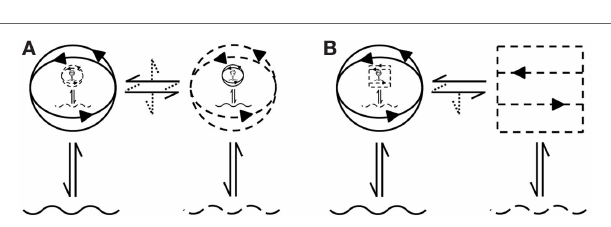
FIGURE 14 | Pictographic representation (Moore, 2016a) of language-based coupling (dialog) between interlocutors. In (A) , communicative interaction between human beings is founded on two-way ostensive recursive mind-reading (including mutual Theory-of-Mind). In (B) , the artificial agent lacks the capability of ostensive recursive mind-reading (it has no Theory-of-Mind), so the interaction is inevitably